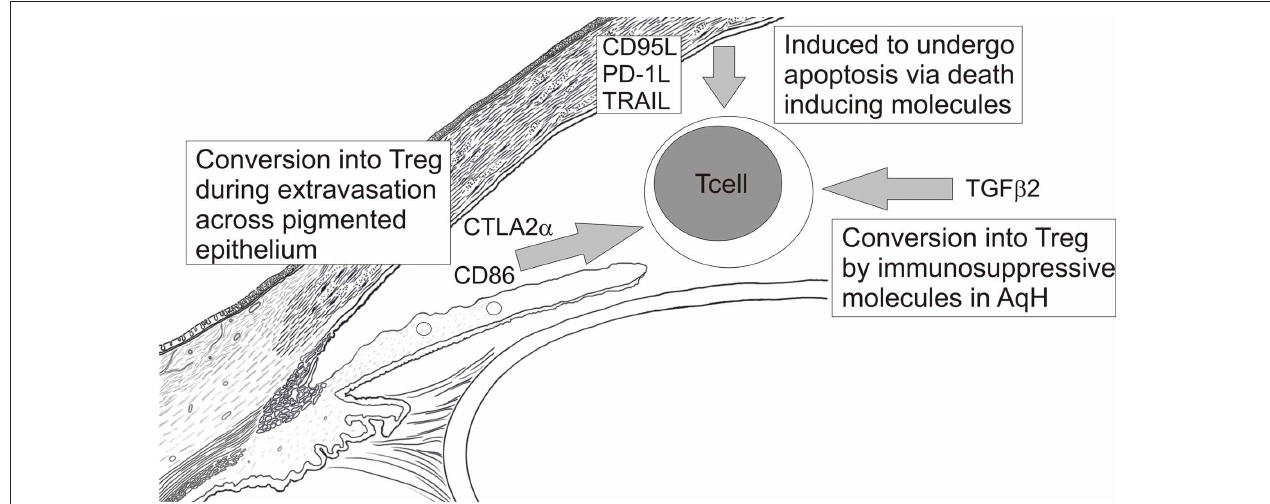
FIGURE 3 | Mechanisms of T cell inactivation within the anterior chamber.